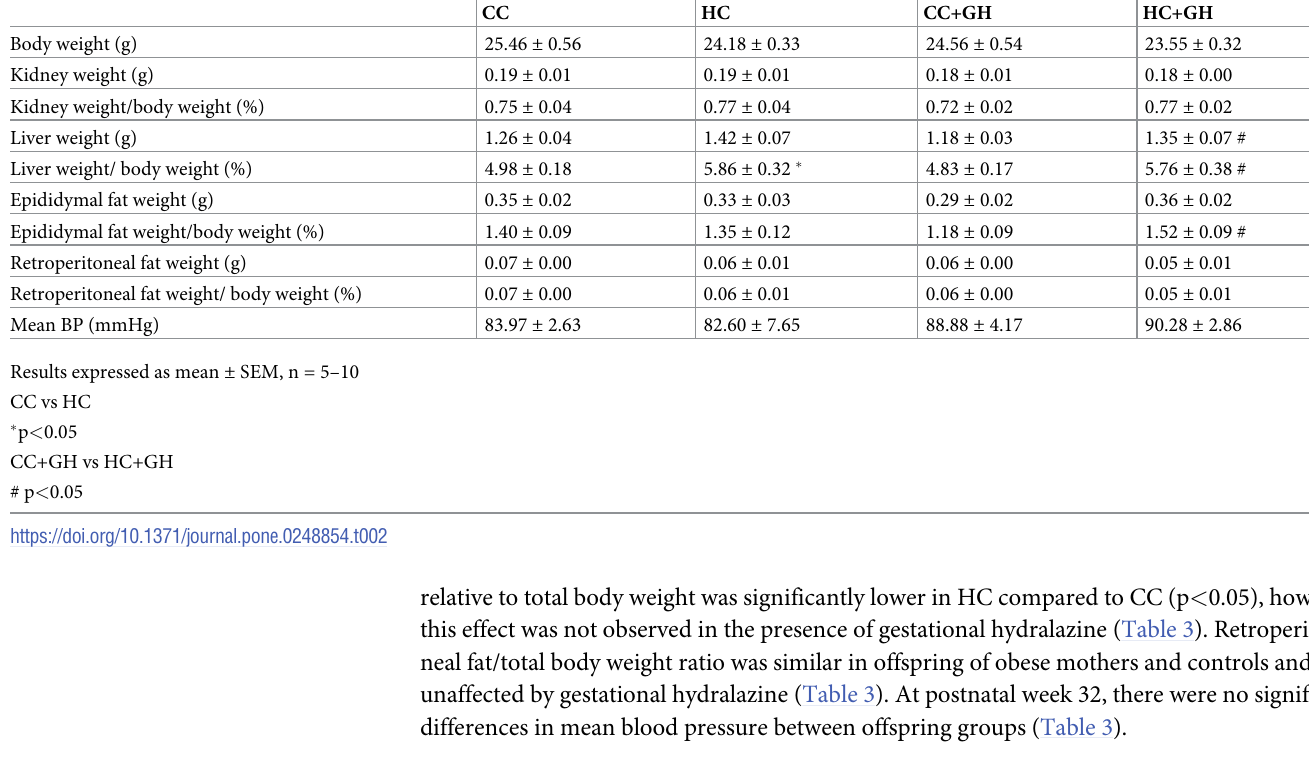
relative to total body weight was significantly lower in HC compared to CC (p < 0.05), however, this effect was not observed in the presence of gestational hydralazine (Table 3). Retroperito- neal fat/total body weight ratio was similar in offspring of obese mothers and controls and was unaffected by gestational hydralazine (Table 3). At postnatal week 32, there were no significant differences in mean blood pressure between offspring groups (Table 3).